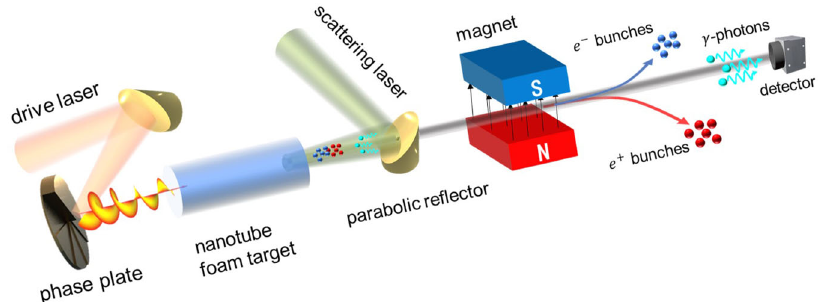
Fig. 6 Proposal of an experiment set-up to acquire high-quality positron beams. The LG laser pulse can be obtained by irradiating a phase plate with a usual Gaussian laser pulse (see Methods), for example, a 16/32 stair phase plate with the stair-height of tens nanometers employed in previous experiments 60 can be used here. Then, the LG laser pulse interacts with the nanotube foam target and collide with the scattering laser, generating abundant γ -ray and electron-positron pairs. Finally, the collimated electron and positron beams can be separated from the laser pulses and γ -ray beams by use of magnetic fi elds.